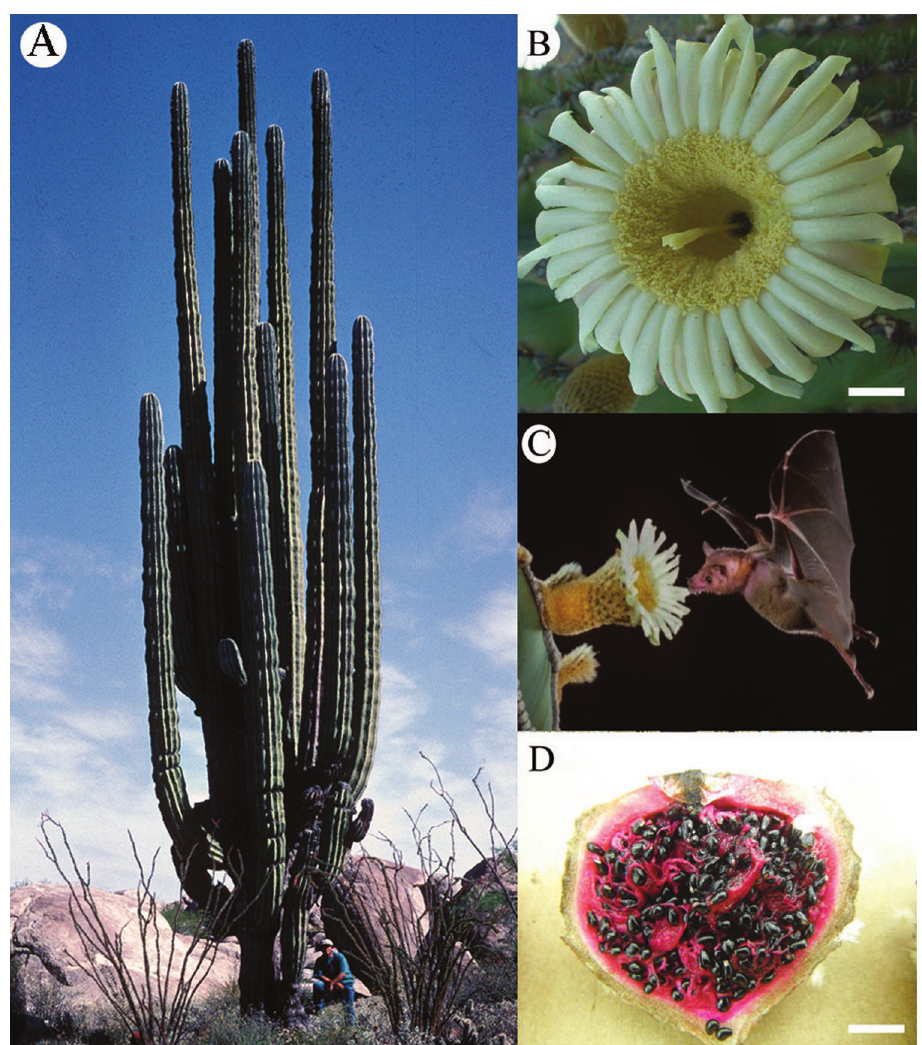
Figure 1. Typical vegetative and floral morphology of the emblematic cactus Pachycereus pringlei. A Mature individual with candelabra-like structure in the Cataviña region. B Archetypal funnel-form flower. C Main pollinator, the long-nosed bat Leptonycteris yerbabuenae . D Mature, fleshy fruit. Photo A by Jon Rebman; photo C by Merlin D.